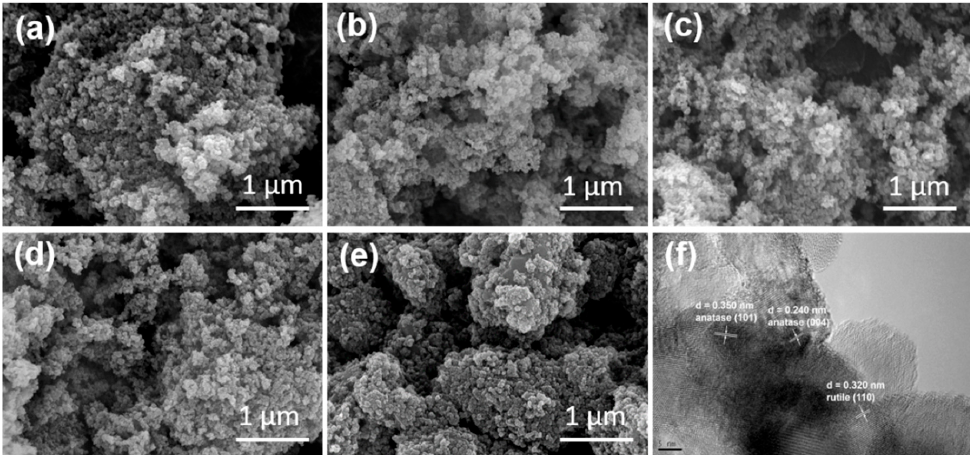
Figure 2. SEM images of ( a ) pure TiO 2 P25, ( b ) TC7.5, ( c ) TC10, ( d ) TC25, ( e ) TC50, and ( f ) HRTEM image of TC10 sample.